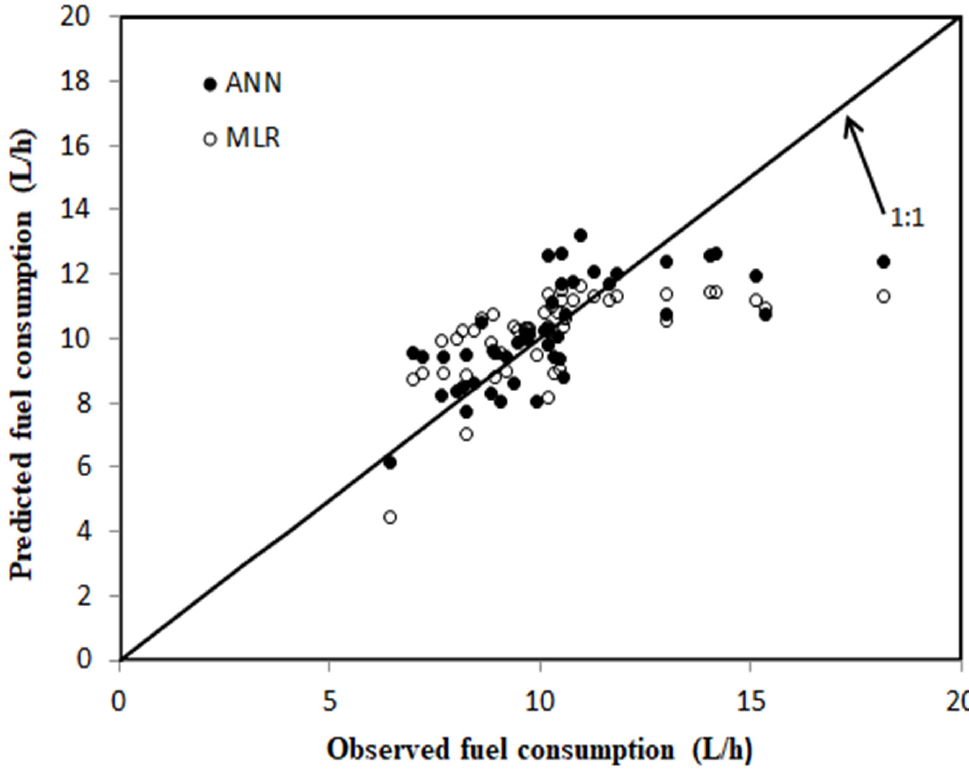
Figure 6. Correlation between the observed and predicted values for the fuel consumption of the ANN and MLR models in the case of the testing dataset.